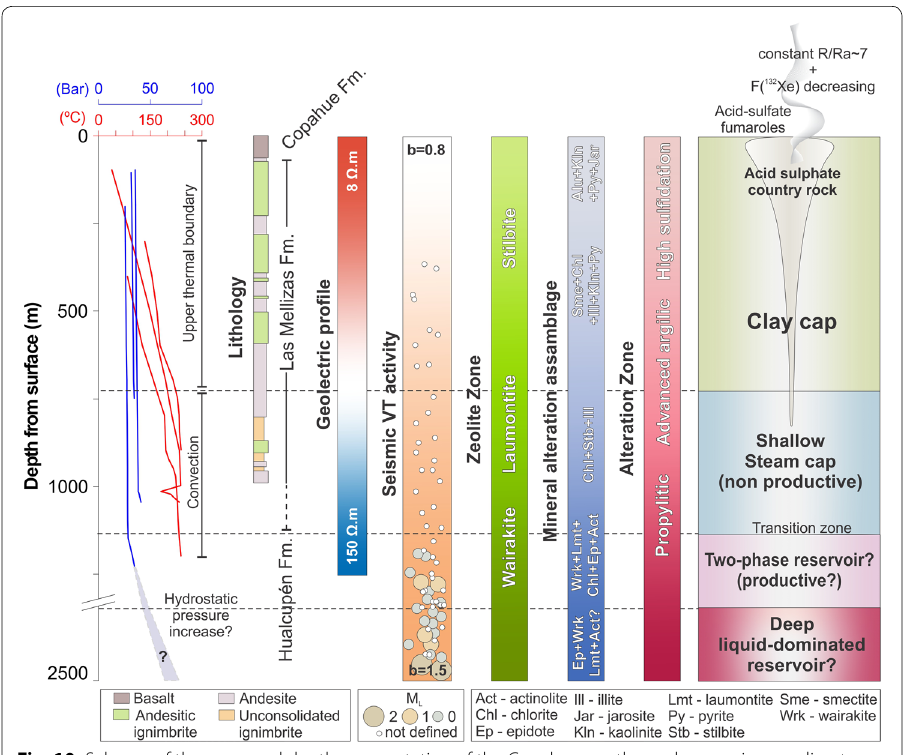
Fig. 10 Scheme of the proposed depth segmentation of the Copahue geothermal reservoir according to geophysical data (JICA 1992; Lazo et al. 2015; Lundgren et al. 2017), well data, fluid geochemistry composition and isotopic abundances (Chiodini et al. 2015; Roulleau et al. 2016), zeolite zone, mineral alteration assemblage (Mas et al. 1995, 1996), and pressure–temperature–depth profiles (JICA